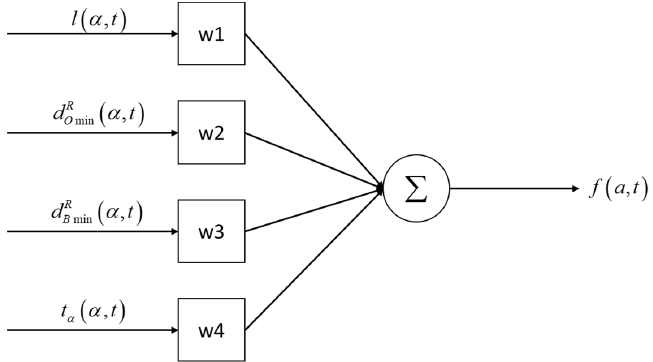
Figure 12. Total weighted factor is recurred by WSM.